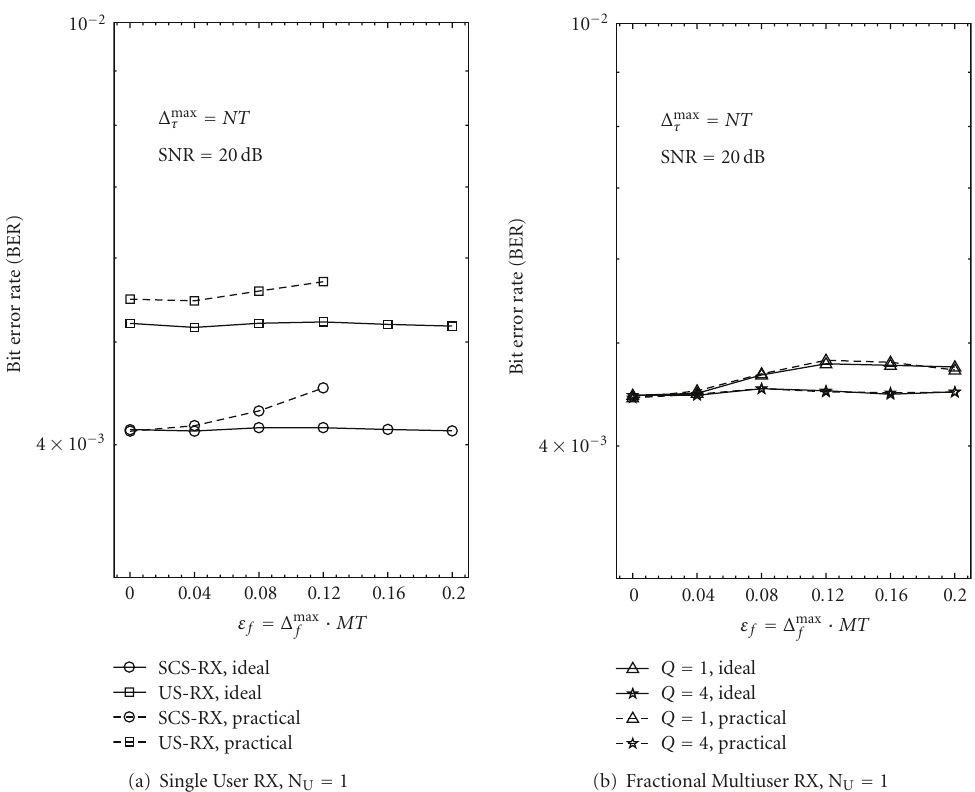
Figure 8: Average BER as a function of the maximum frequency o ff set. Ideal and practical performance with 1 user. The training sequence length is equal to 30